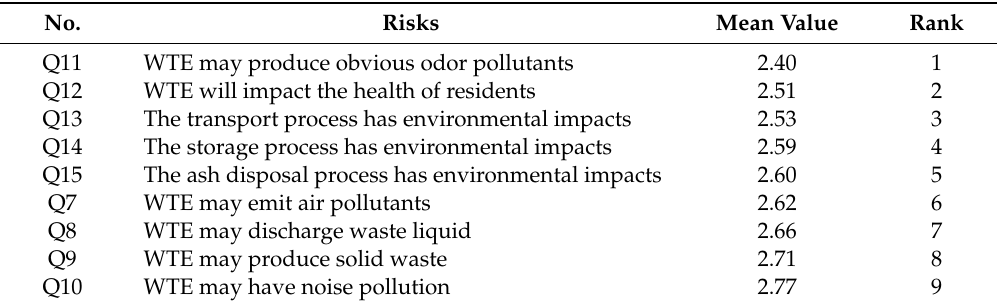
Table 6. Mean value of the PR of